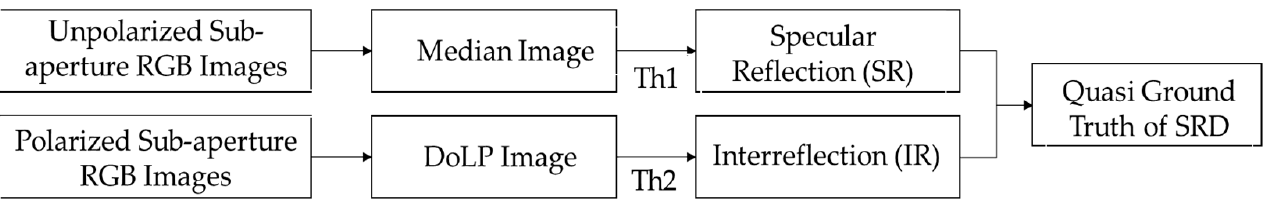
Figure 8. Quasi-ground truth of